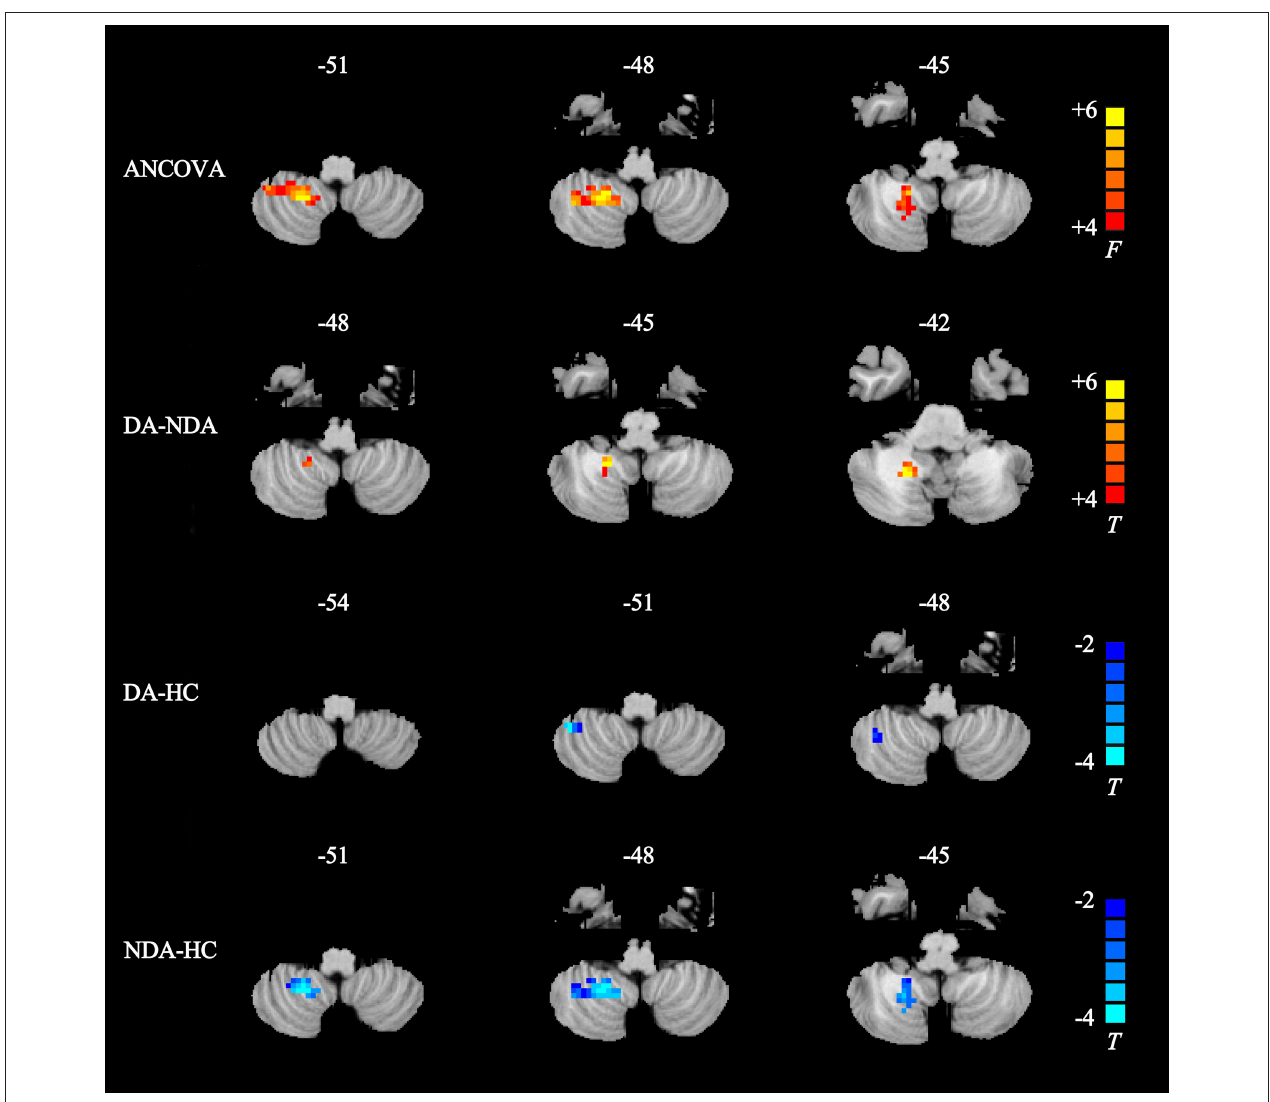
FIGURE 2 | Statistical maps showing rCBF differences in different brain regions between DA, NDA, and HC groups. ANCOVA, significantly increased in rCBF among DA, NDA and HC groups ( P < 0.025, AlphaSim corrected); Higher rCBF was in the right cerebellum posterior lobe; the red color bar indicates the F- value from ANCOVA among three groups. DA-NDA, significantly increased in rCBF of DA patients compared with NDA patients ( P < 0.025, AlphaSim corrected); the DA patients showed higher CBF in the right cerebellum posterior lobe; the red color bar indicates the t value from independent sample t -test between DA and NDA groups. DA-HC, significantly decreased in rCBF of DA patients compared with HC ( P < 0.025, AlphaSim corrected); the DA patients showed lower rCBF in the right cerebellum posterior lobe; the blue color bar indicates the t value from independent sample t -test between DA and HC groups. NDA-HC, significantly decreased in rCBF of NDA patients compared with HC patients ( P < 0.025, AlphaSim corrected); the NDA patients showed lower rCBF in the right cerebellum posterior lobe; the blue color bar indicates the t value from independent sample t -test between NDA and HC groups. ANCOVA, analysis of covariance; DA, depressed asthma; NDA, non-depressed asthma; HC, healthy